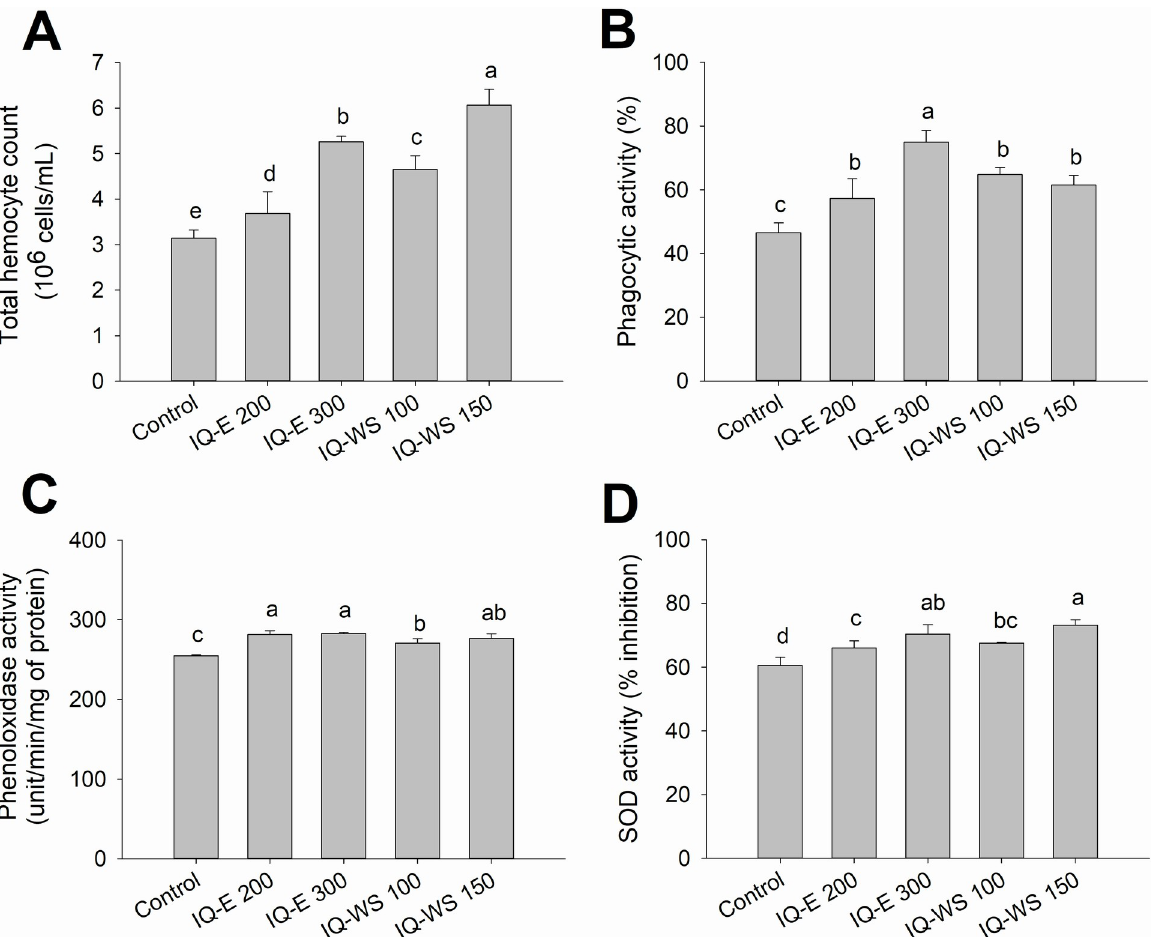
Fig 1. Effects of IQ extracts on immune parameters of the healthy shrimp. Total hemocyte count (10 6 cells/mL) ( A ), phagocytic activity (%) ( B ), phenoloxidase activity (unit/min/mg of protein) ( C ), and superoxide dismutase (SOD) activity (% inhibition) ( D ) of the shrimp ( n = 5) fed the control diet, IQ-E at 200 or 300 mg/kg of feed, and IQ-WS at 100 or 150 mg/kg of feed on day 30. The data are presented as the mean ± standard deviation. Different letters above the bars indicate significant differences ( p < 0.05).